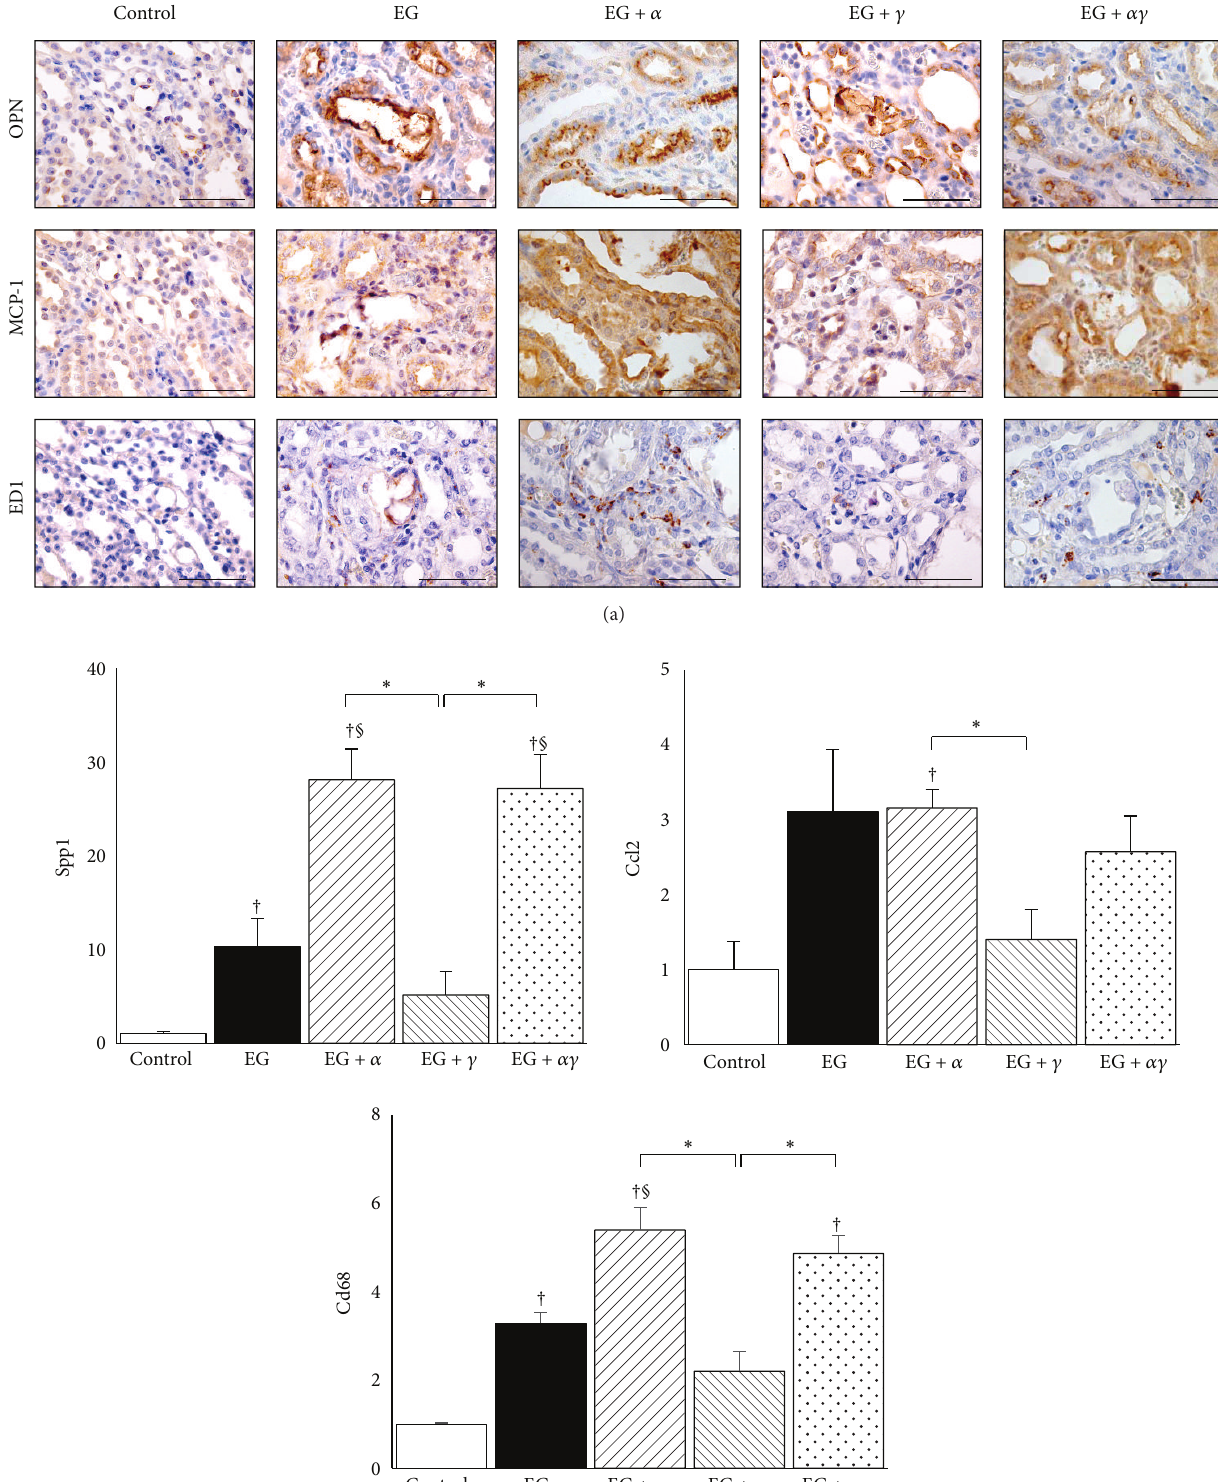
Figure 4: Proinflammatory gene expression in model rat kidneys. (a) Distribution of proinflammatory-related gene expression in rat kidneys obtained on day 14. OPN, osteopontin; MCP-1, monocyte chemoattractant protein-1. Magnification: 400x. Scale bar = 50 𝜇 m. (b) Gene expression was assessed by qRT-PCR using TaqMan assays ( 𝑛 = 6 for all groups). Data are presented as mean ± SE. ∗ 𝑝 < 0.05 among EG + 𝛼 , EG + 𝛾 , and EG + 𝛼𝛾 groups; † 𝑝 < 0.05 compared with the control group; § 𝑝 < 0.05 compared to the EG